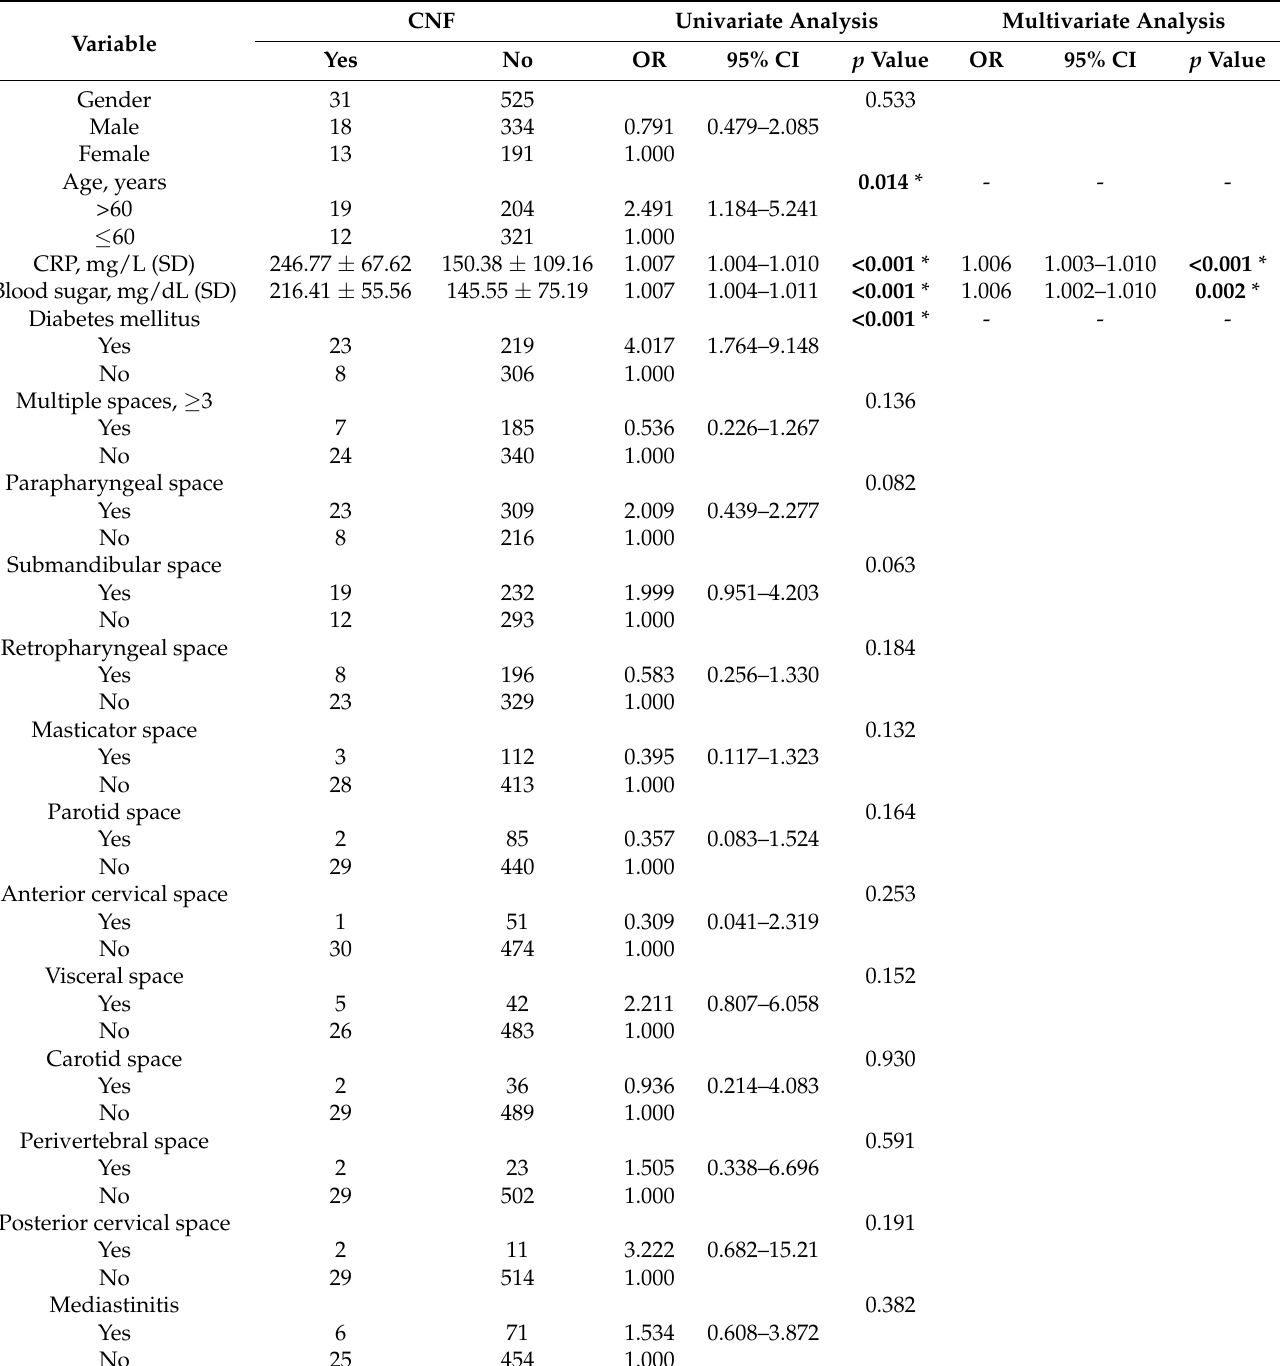
Table 2. Univariate and multivariate analyses of 525 patients with DNI alone compared to 31 patients with concurrent DNI and CNF.